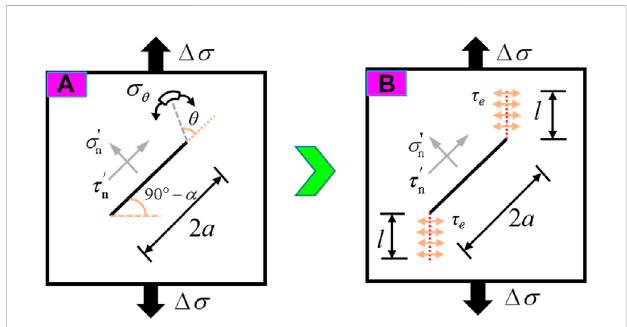
FIGURE 4 Schematic of the initiation and propagation of secondary cracks under the mining stress state: (A) secondary crack initiation and (B) secondary crack